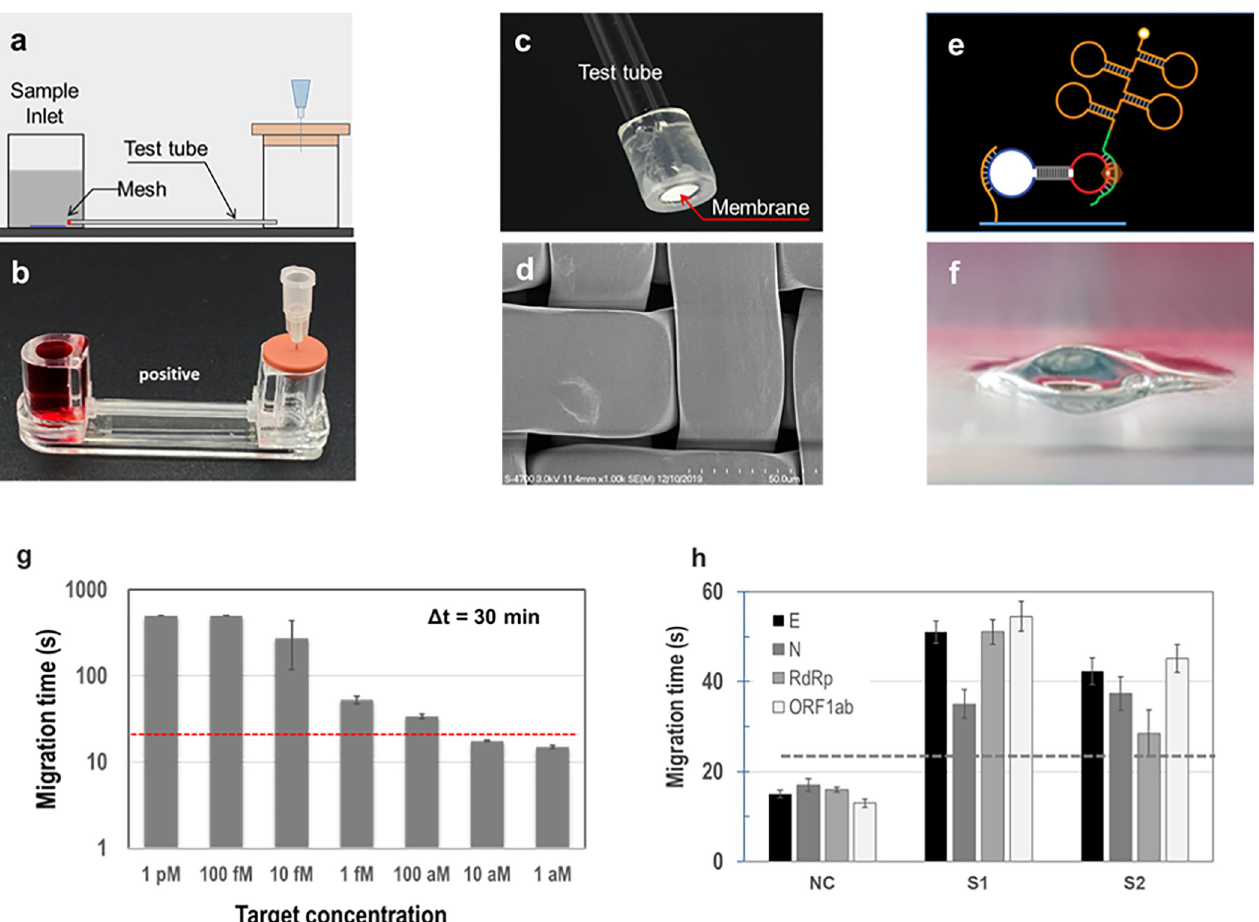
Fig 4. (A) Schematic of RCA-flow with microfluidics; (B) photograph of an integrated microfluidic system with RCA detection for SAR-CoV-2; (C) photograph of a test tube with nylon mesh; (D) SEM photograph of the nylon mesh having microscale pores; (E) schematics of RCA on mesh surface; (F) hydrogel formation through RCA reaction with RNA obtained from clinical mask sample; (G) calibration chart with various concentrations of synthetic RNA; (H) RCA-flow results (migration time) with clinical mask samples.